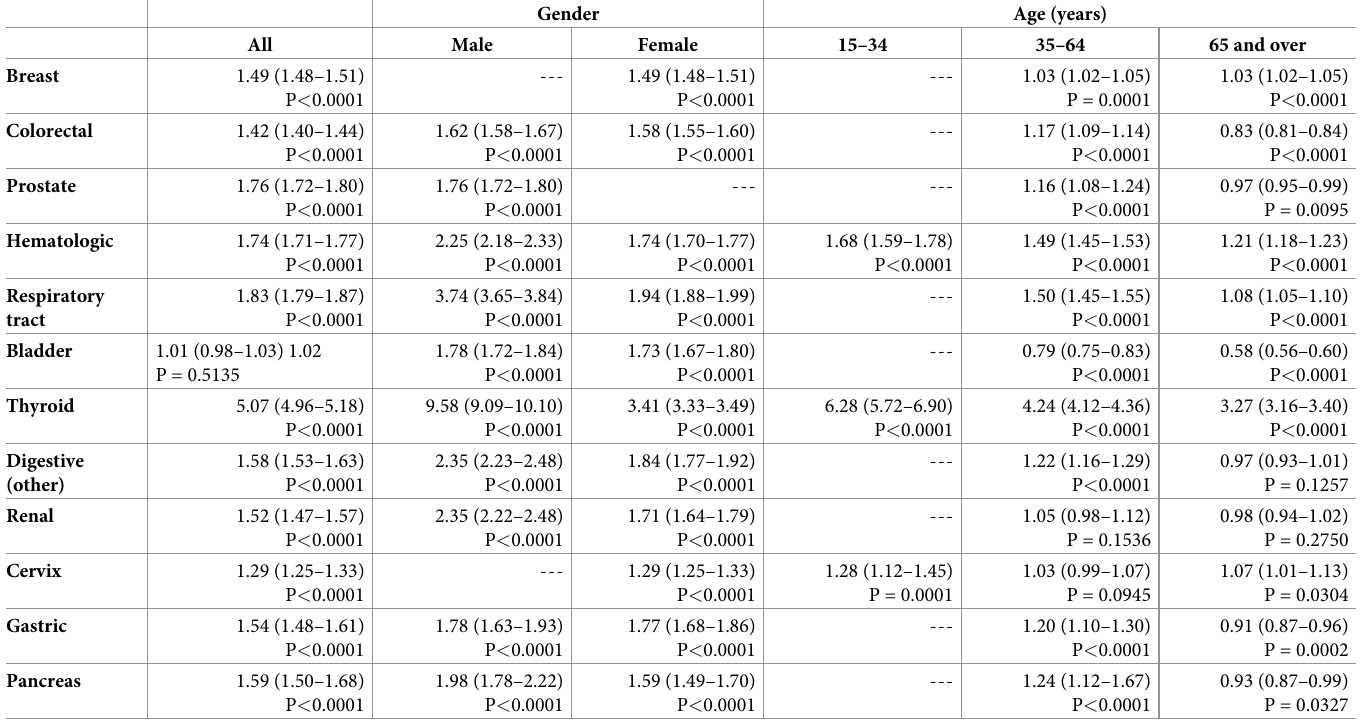
Table 3. Relative risk of different types of malignancies in patients with hypothyroidism classified by age and sex.